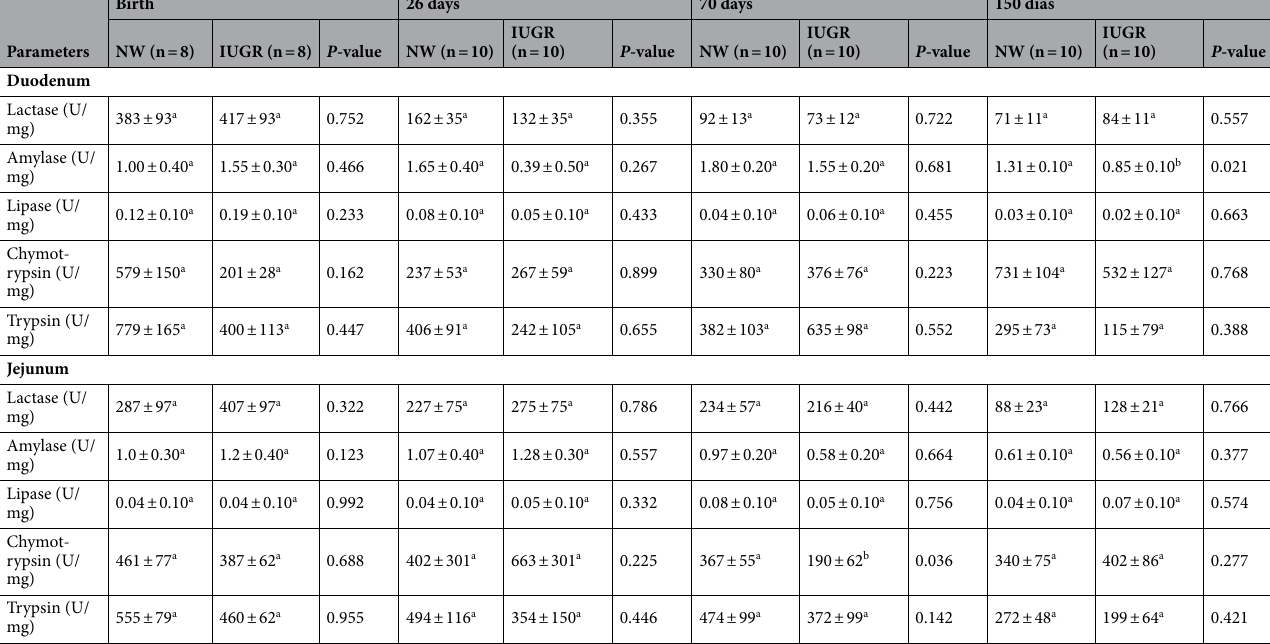
Table 4. Enzymatic activity in the small intestine enzymes from normal (NW) and intrauterine growth restricted (IUGR) male littermate pigs throughout the production phases. ab Within the same age, least square means with different superscripts within a row differ (P <